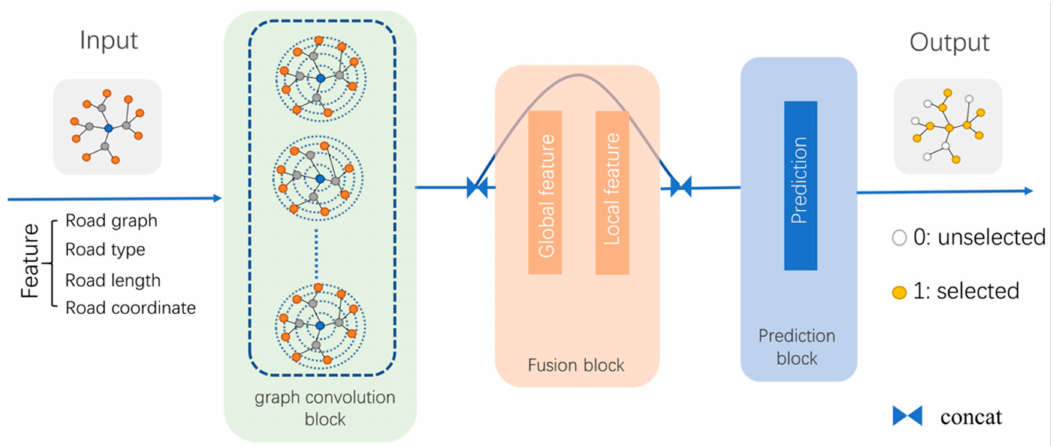
Figure 4. Components of our selection